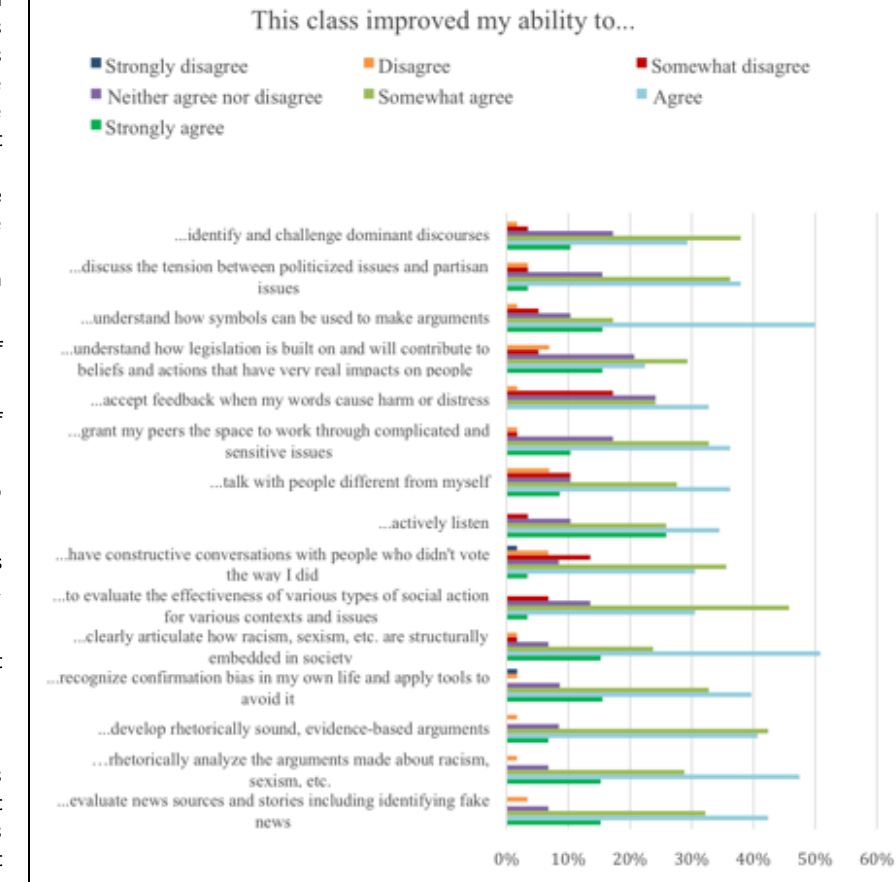
FIGURE 1. RESULTS OF STUDENT SURVEY TARGETING EACH OF THE COURSE